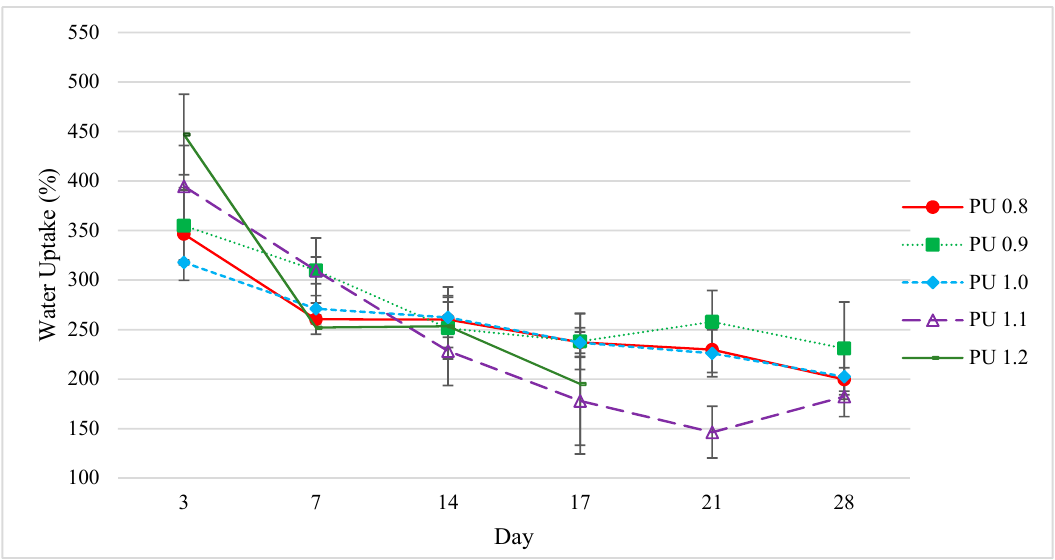
Figure 7. Water uptake of polyurethanes produced by PPP using different isocyanate indices after enzymatic degradation test (Mean ± SD, n = 3). * PU 0.8, PU 0.9, PU 1.0, PU 1.1, PU 1.2 were prepared by reacting palm oil-based polyester polyol with IPDI at isocyanate index of 0.8, 0.9, 1.0, 1.1 and 1.2, respectively.